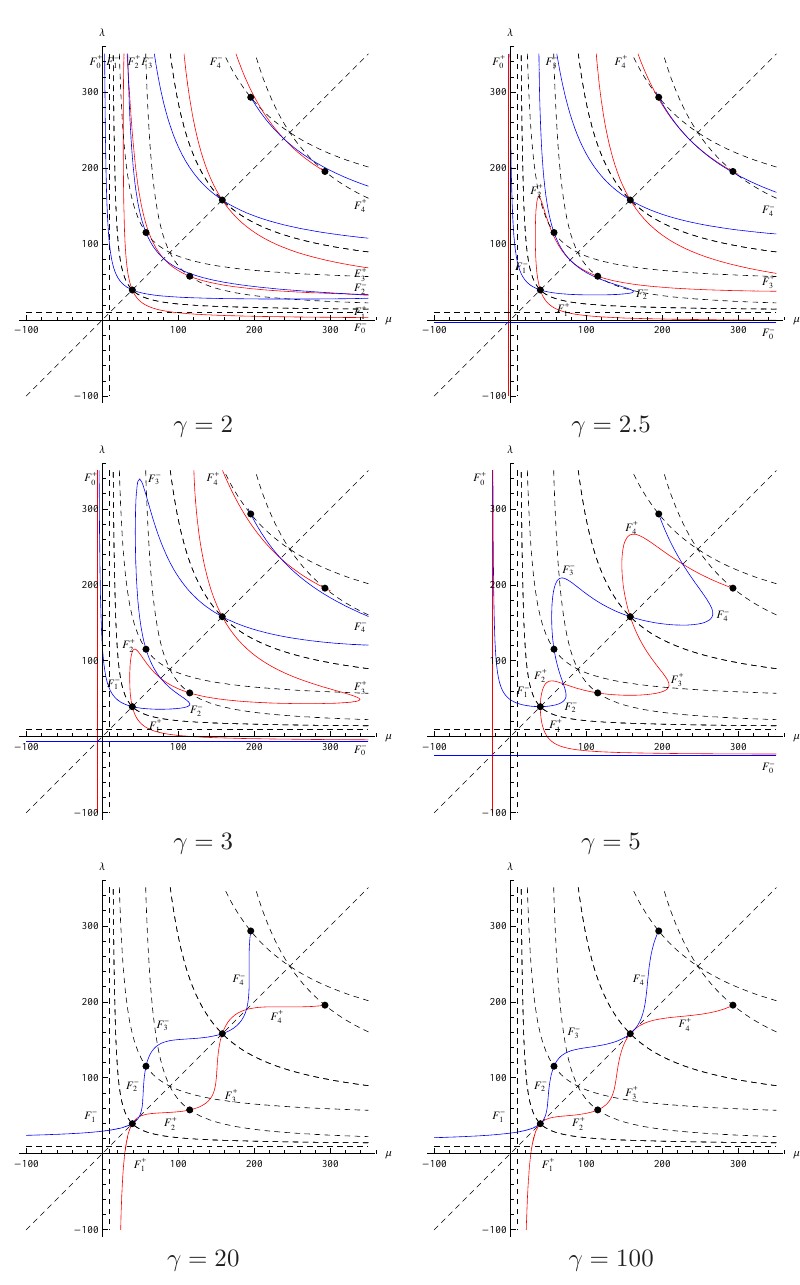
Figure 4. The spectrum for the problem (1.1), (1.4) for different γ